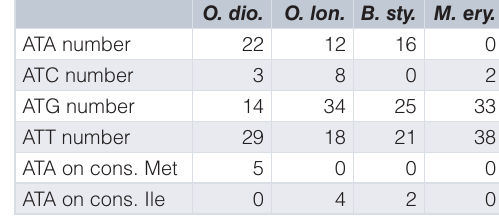
Table 1. ATN codons in Cox1 in Oikopleuridae.